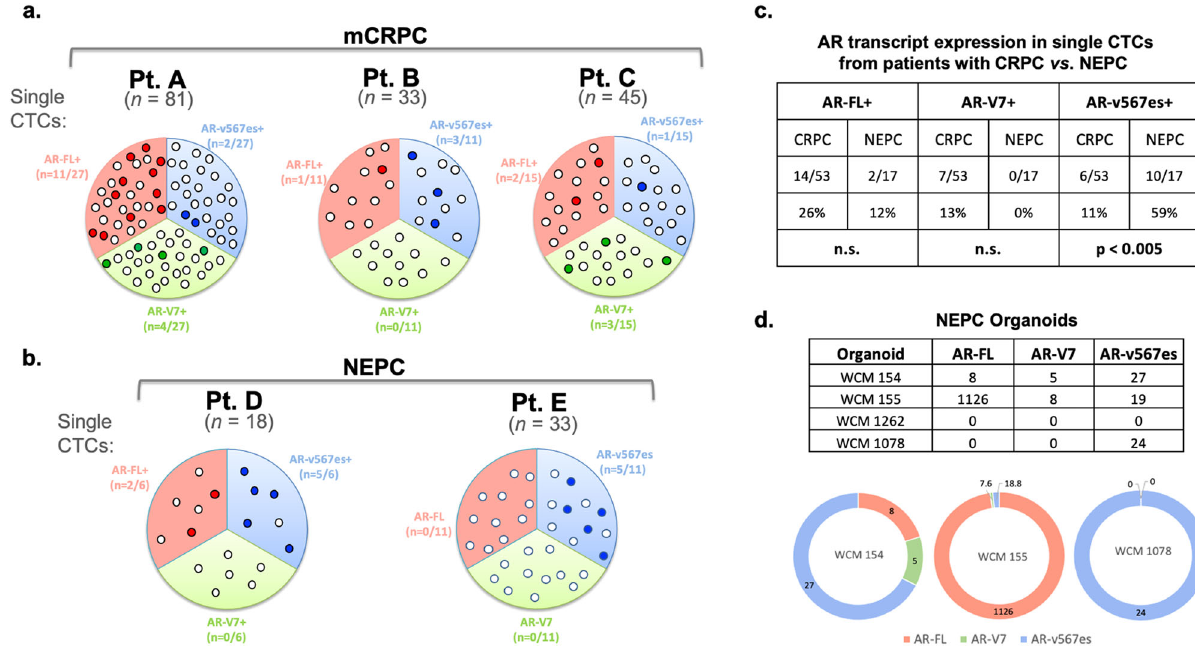
Fig. 4 Expression of AR-FL, AR-V7, and AR-v567es in single CTCs and organoids from patients with mCRPC and NEPC. a Single CTCs were isolated from three patients with mCRPC (A, B, C) and b two patients with NEPC (D, E) and processed for quanti fi cation of each AR transcript by ddPCR. Big circles represent individual patients and small circles represent single CTCs. (For patient A: we have single 81 CTCs, for patient B we have 33 CTCs, for patient C we have 45 CTCs, for patient D we have 18 CTCs and for patient E we have 33 CTCs). The total CTCs isolated from each patient were divided into three equally sized groups and each group was tested for only one of the three transcripts (For example, for patient A, we analyzed 27 single CTC for the expression of AR-FL, 27 single CTCs for the expression of AR-V7 and 27 single CTCs for the expression of AR-v567es). Colored small circles for each transcript represent positive expression, while white circles represent CTCs negative for the respective transcript. The CTCs positive for AR-FL shown in red circles; AR-V7, green circles; and AR-v567es, blue circles. c Prevalence of each transcript across in single CTCs from patients with CRPC vs. NEPC. Statistical signi fi cance was determined using two-tailed Fisher Exact test, n.s.; not signi fi cant for AR-FL + and AR-V7 + ; p = 0.0002 in AR-v567es + CTCs. d Table shows expression levels for each transcript in four patient-derived NEPC organoids. Data displayed in a doughnut format for three of the four organoids offer a visual display of relative transcript abundance. Transcript color coding as indicated. Data shown are copies per sample normalized to input RNA and internal loading expressing AR-FL, 3 CTCs expressing AR-V7, and 1 CTC positive previous report on single CTC RNA-Seq from prostate cancer for AR-v567es making AR-V7 the predominant transcript patients 21 . For example, patient A had 11 CTCs expressing AR- FL, 4 CTCs expressing AR-V7, and 2 CTCs expressing AR- (Fig. 4a). v567es; making AR-FL the predominant transcript. In contrast, A similar analysis of single CTCs enriched from patients with patient B had 1 CTC expressing AR-FL, 0 CTCs expressing AR- V7, and 3 CTCs expressing AR-v567es, which was the pre- dominant transcript in this patient. Patient C had 2 CTCs